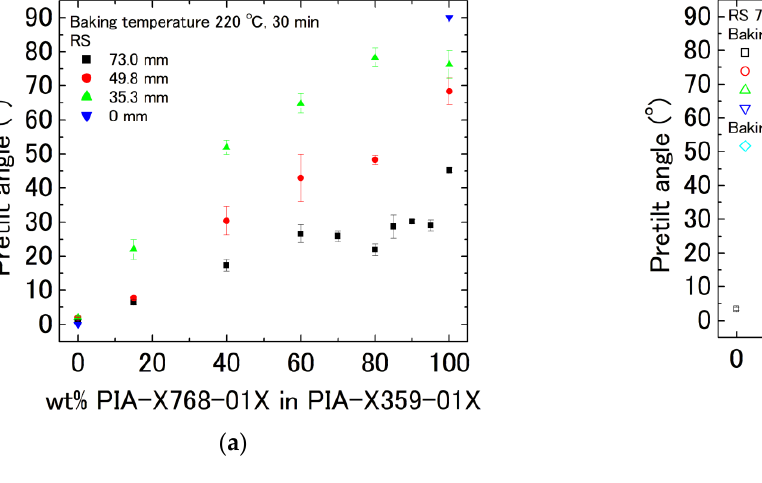
Figure 2. Pretilt angle vs. relative concentration of vertical to horizontal alignment film for ( a ) PIA- X768-01X and PIA-X359-01X and ( b ) SE-4811 and SE-150.